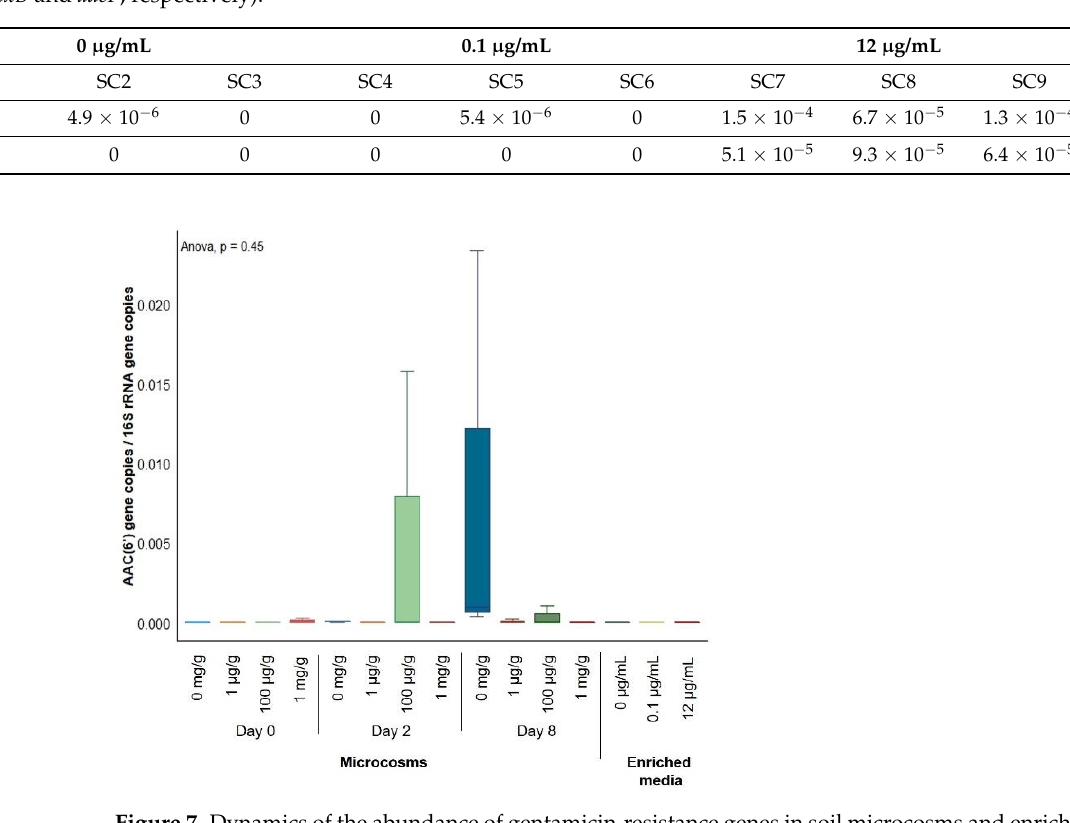
Figure 7. Dynamics of the abundance of gentamicin-resistance genes in soil microcosms and enriched media with and without gentamicin. Number of copies of gentamicin-resistance genes from the AAC(6′) aminoglycoside acetyltransferase family per µL of qPCR reaction normalized by the number of copies of the 16S rRNA gene per µL of qPCR reaction.No significant differences were found between conditions (each gentamicin concentration and each exposure time for soil microcosms and each gentamicin concentration after 24-h exposure for bacterial enrichments). n =